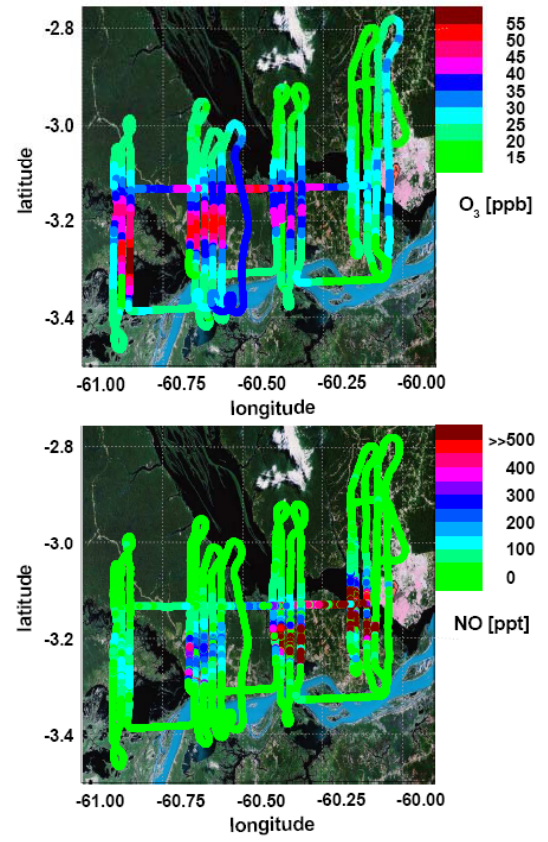
Fig. 6. Bird view image (see Fig. 1) of O 3 and NO mixing ratios ob- served downwind of Manaus City ( − 3.08 ◦ , − 60.01 ◦ ) during Flight #18 on 19 July 2001, 10:00–14:00LT. The linear colour code of NO (lower panel) was selected to resolve values of 0–500ppt, while the dark red colour in the vicinity of Manaus City includes values up to 10 ppb of NO (see Fig. 4). For O 3 (upper panel) one transect (70km distance, 550m level) was interpolated due to lack of data. As flight legs at a certain distance of Manaus lie on top of each other (com- pare Figs. 1, 2), perspective is added in a way that highest altitudes transects are displayed on most right-hand side. One longitudinal degree corresponds to ∼